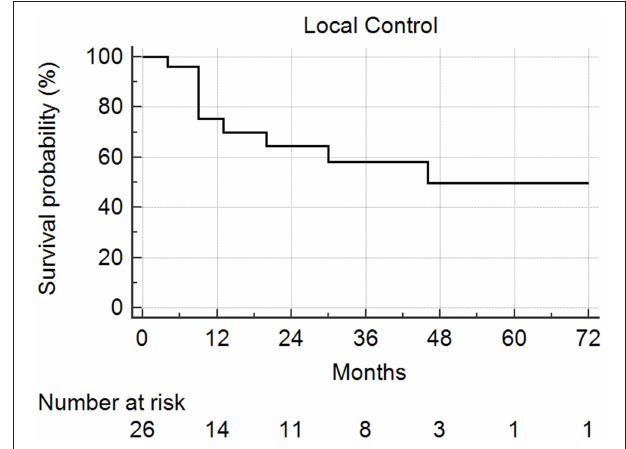
FIGURE 2 | Local control following SBRT for lung metastases. Local control at 1 and 2 years was 82 and 74%, respectively.